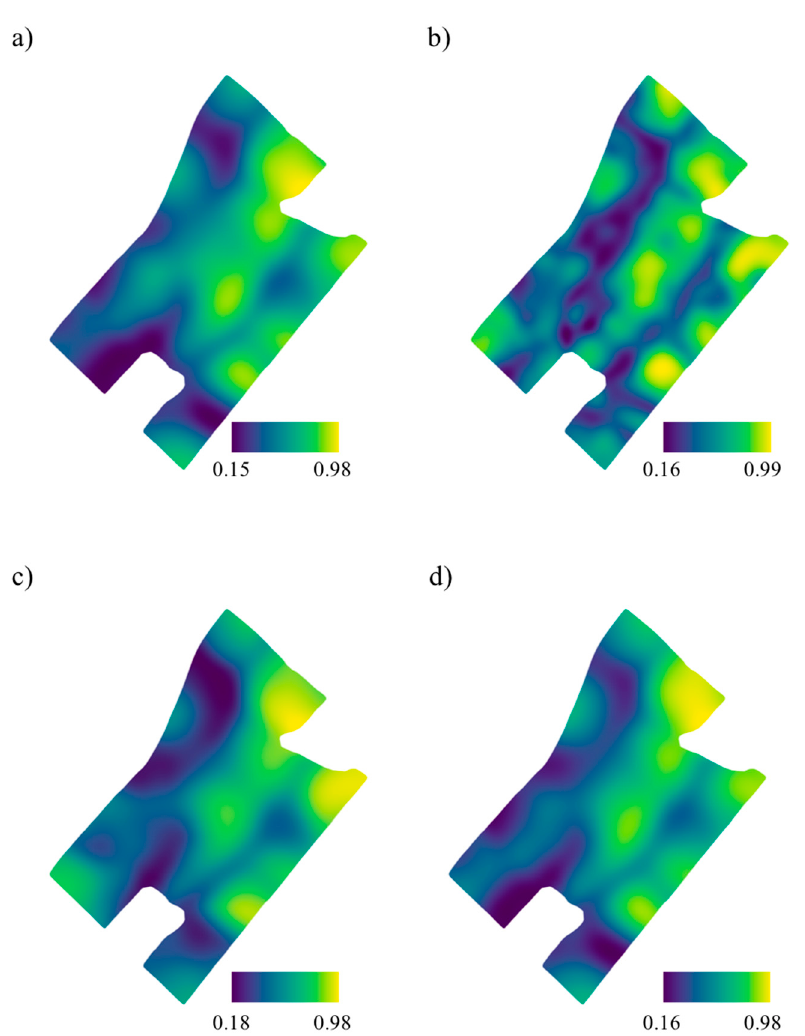
Figure 4. Spatial patterns of R 2 for ( a ) all crops; ( b ) corn; ( c ) winter wheat; ( d ) soybeans. For predicting crop yield, each GWR model was developed during the model training phase using different combinations of the topographic indices reported in Table 2. The frequency that the selected GWR used a specific topographic index is reported in Table 4. Although the wetness index was determined to be individually correlated with yield variance, it was not included in the any of the constructed models because of its high local and global collinearity with slope and relative topographic position. Relative topographic position and slope were included in each of the created models. The GWR model created to predict corn yield also included circular variance of aspect as an explanatory variable, which boosted prediction accuracy in regions where relative topographic position and slope explained low yield variance. The GWR developed for predicting wheat yields included both circular variance of aspect and downslope index as input variables. Downslope index was only used by the model to predict soybeans